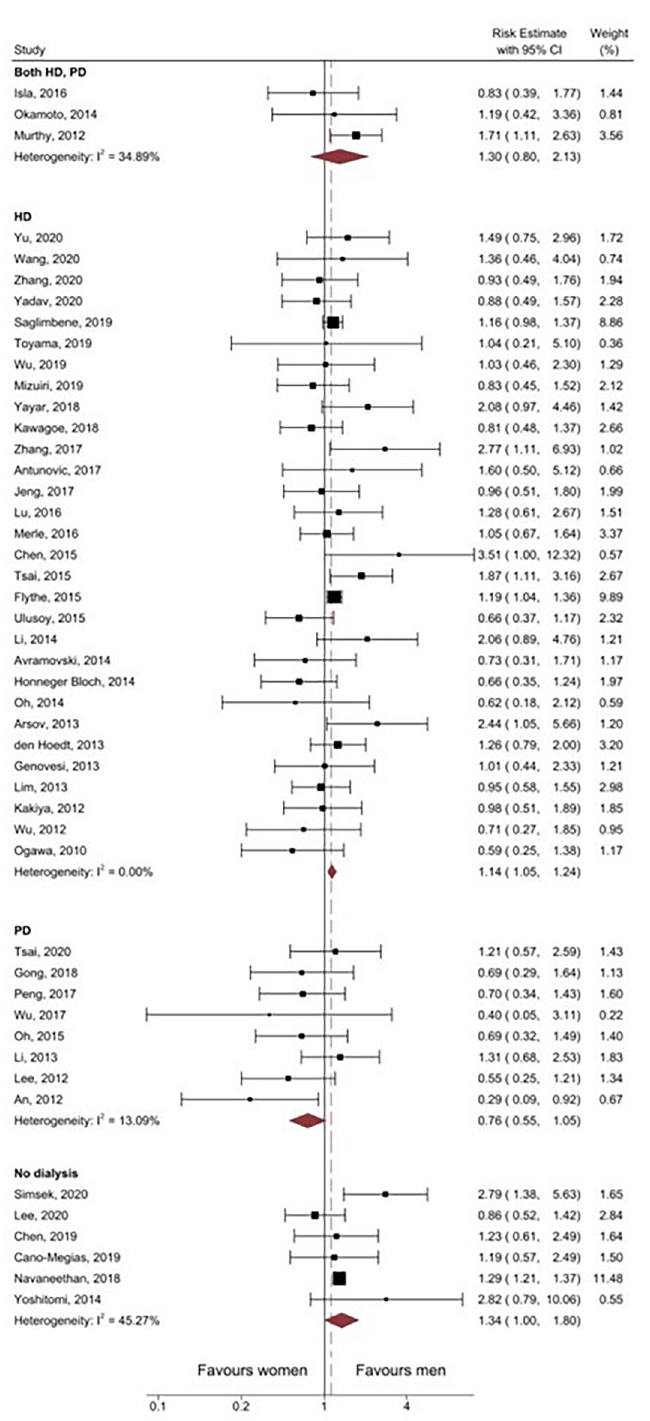
Fig 6. Forest plot of subgroup analysis by dialysis modality of risk estimates of all included studies. CI, confidence interval. I 2 , Measure of heterogeneity. HD, Haemodialysis. PD, Peritoneal dialysis.